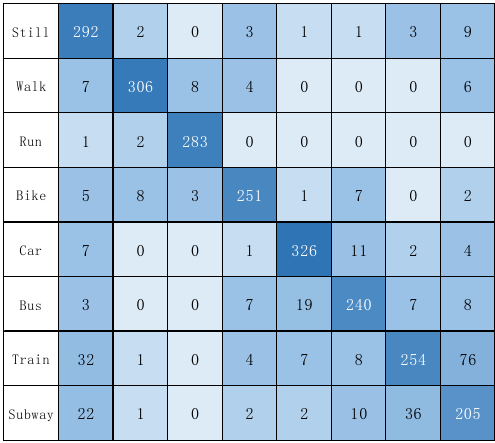
Figure 11. The confusion matrix of DFTrans on the SHL dataset.